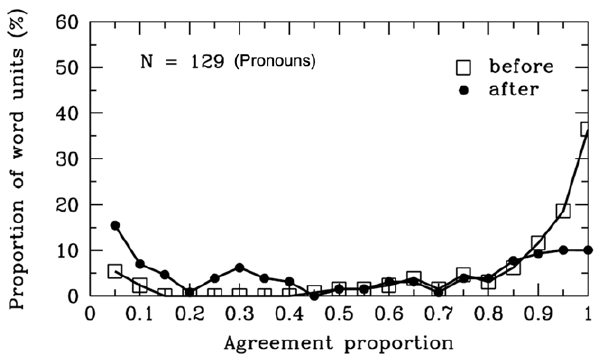
Figure 13. Pronouns. Frequency distribution of agreement propor- tions for word boundaries before (open squares) and after (filled circles) the pronouns. The y-axis represents the proportion of SWU. The number of SWU is also represented in the